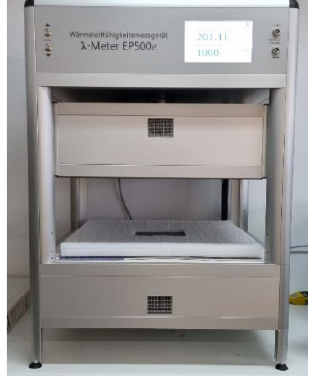
Figure 9. λ -meter machine setup.